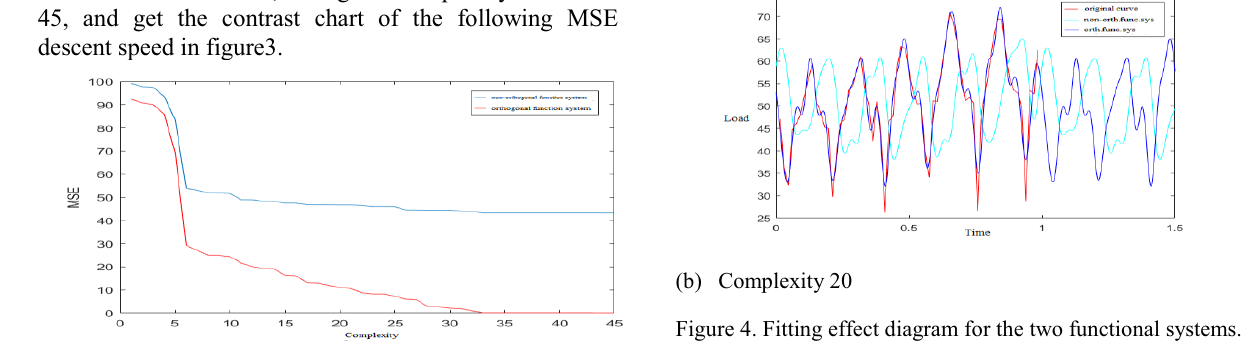
Figure 3. Comparison of the two functional systems for MSE descent speed.